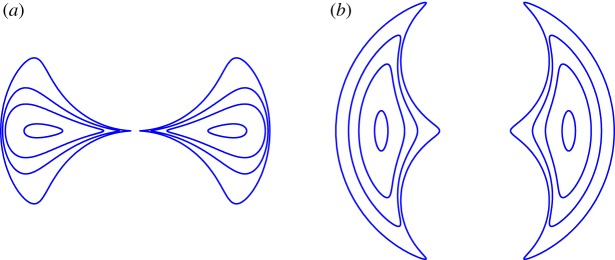
(a,b) Typical two-pore shapes described by the mapping (3.1) for θ=π/3 (a) and θ=2π/3 (b) and ρ=0.005, 0.05, 0.1 and 0.2 (superposed) with centroids fixed. The elastic body is the unbounded doubly connected region exterior to the pores. For small area and θ=2π/3, the pores are near ellipses with semi-axis ratio 1 : 3.